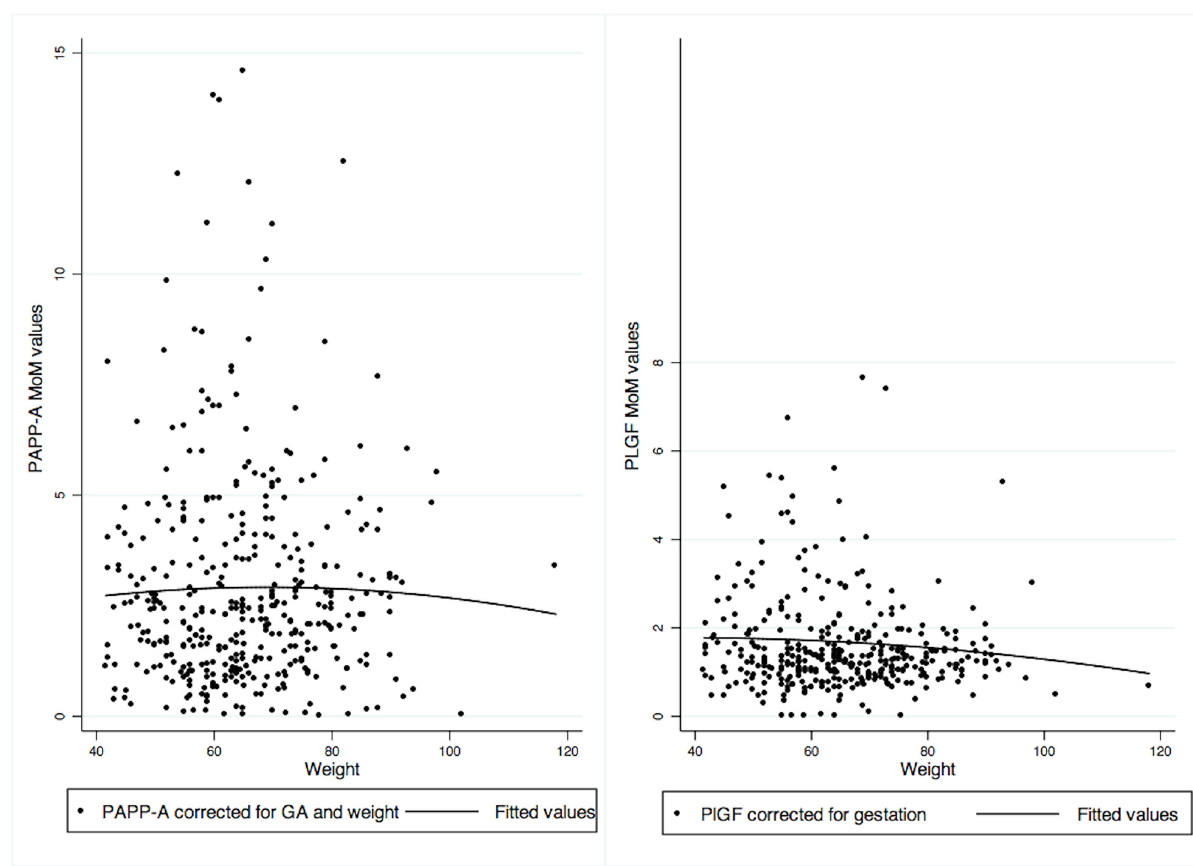
Fig 2. PAPP-A and PlGF MoM values with fitted regression line. PAPP-A regression equation: y = 1.7085 + 0.03512 x − 0.00025 x 2 . PlGF: y = 1.6012 + 0.00938 x − 0.0013 x 2